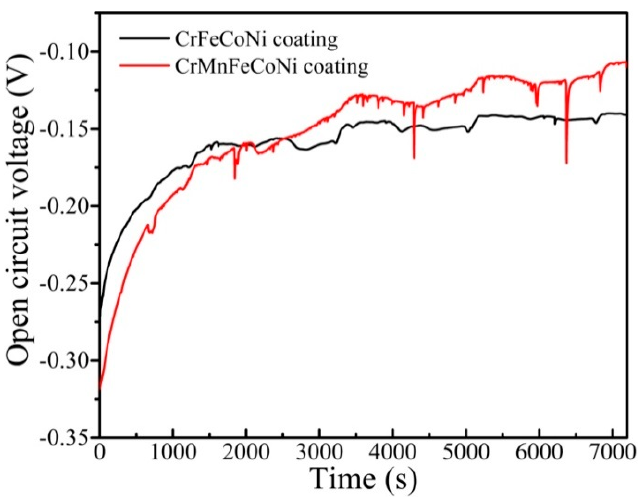
Figure 4. Open circuit potential of the CrFeCoNi and CrMnFeCoNi coatings in 3.5 wt% NaCl solution.